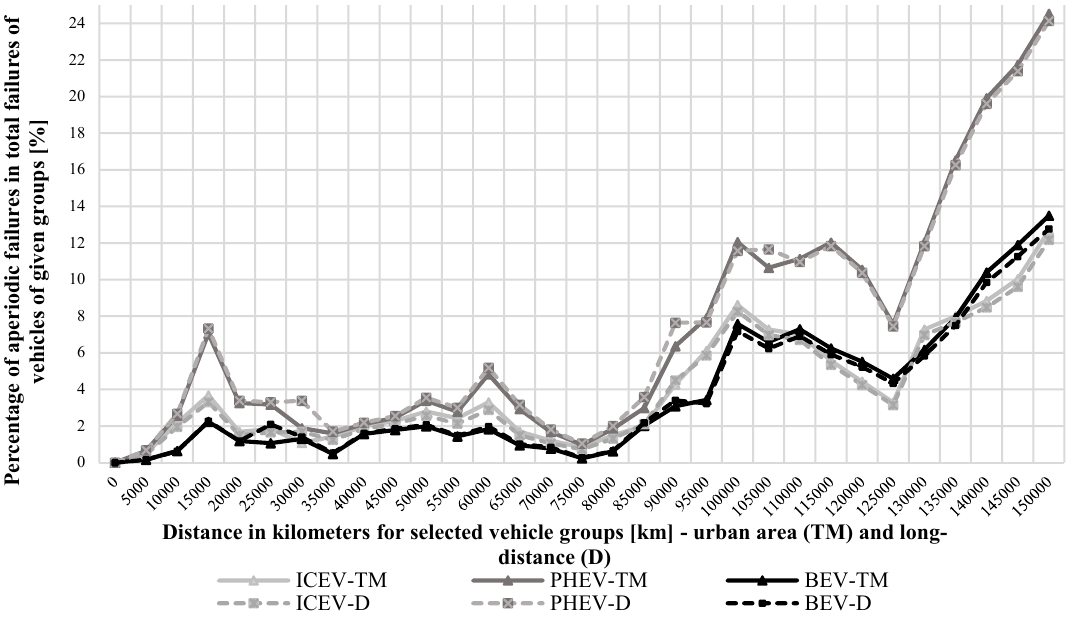
Figure 10. Distribution of aperiodic failures for a medium multiperson vehicle with ICEV, PHEV, and BEV propulsion for urban and long-distance speed profiles over a distance of 150,000 km.